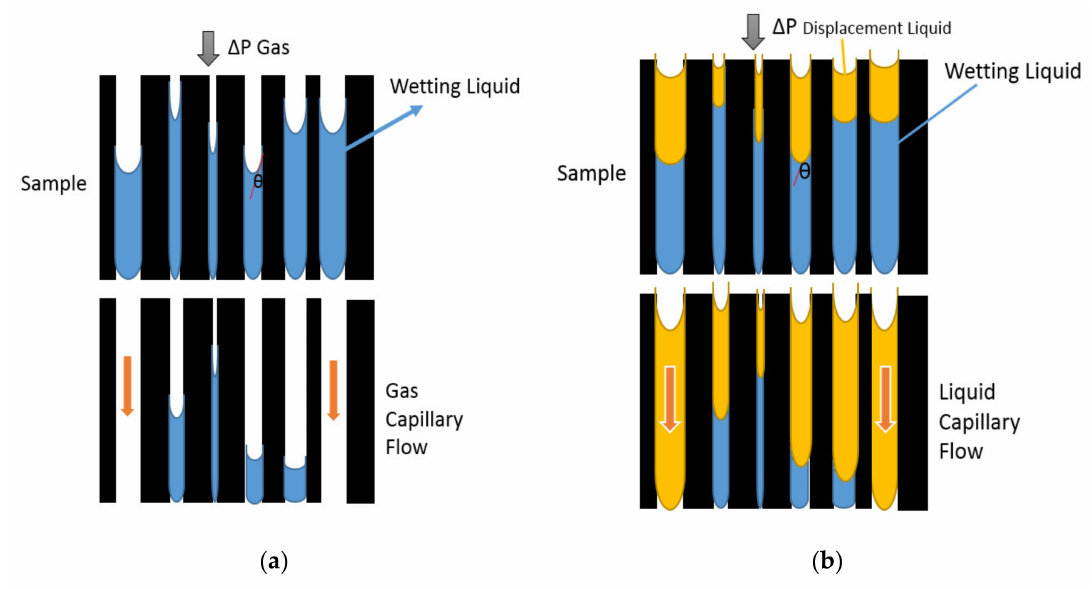
Figure 2. ( a ) Young–Laplace based techniques for gas liquid displacement; ( b ) liquid